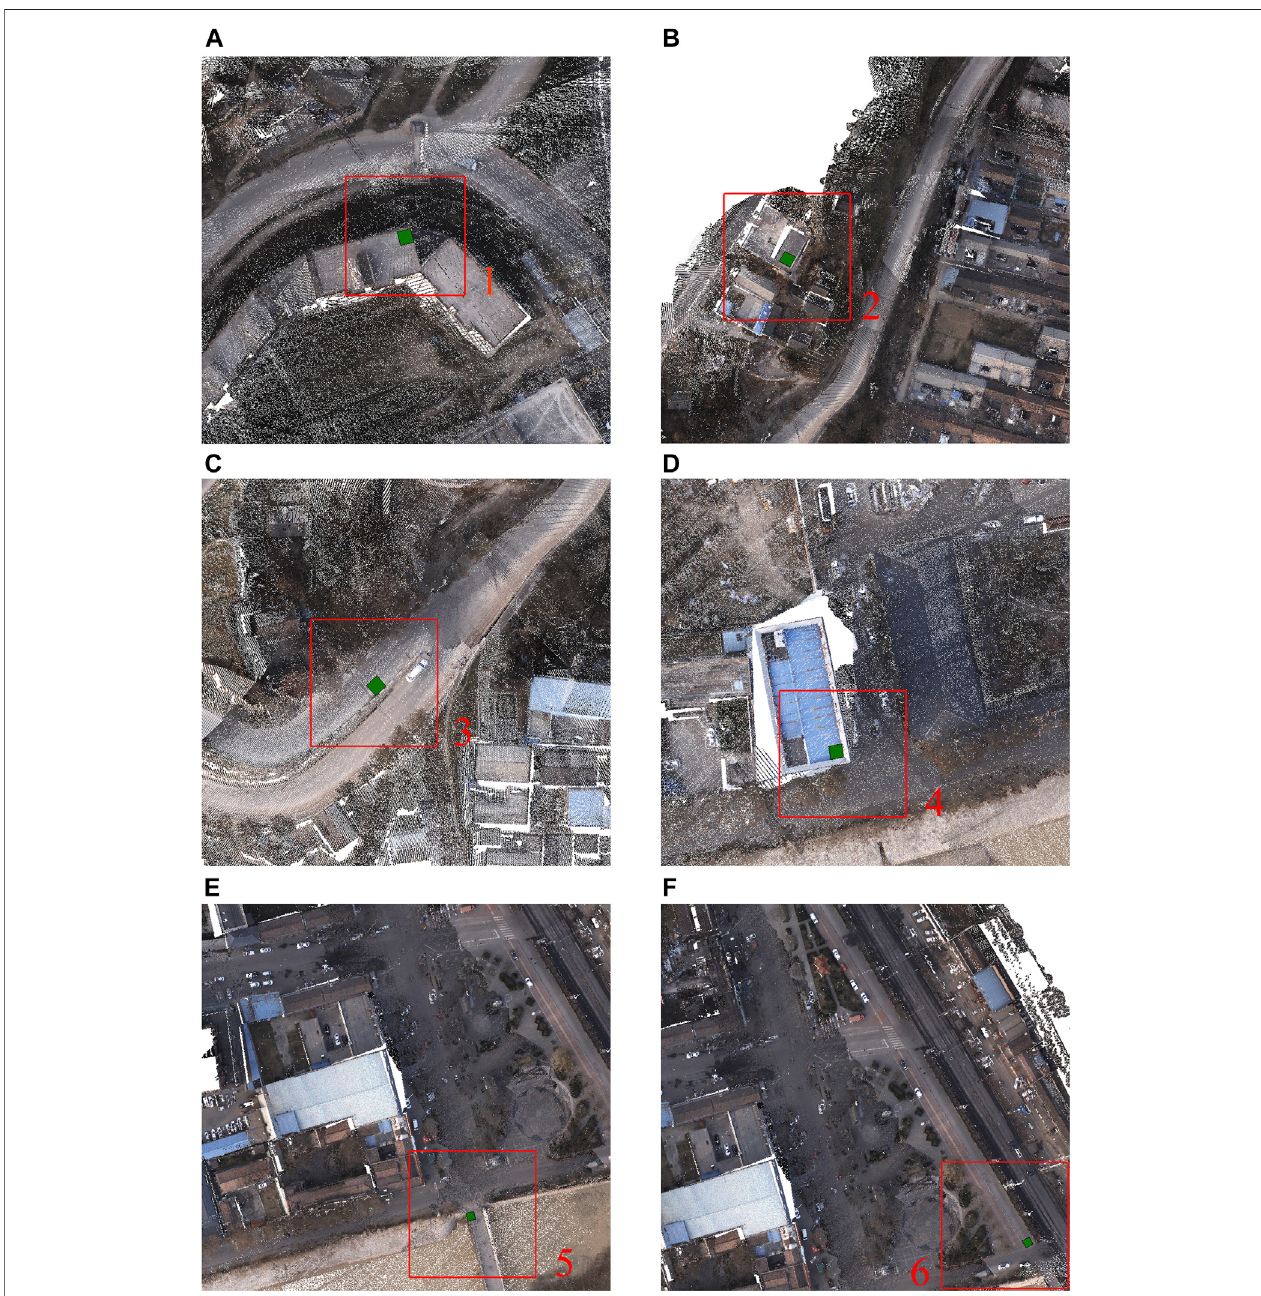
FIGURE 11 | Sketch map of datum point. (A) , (B) , (C) , (D) , (E) , and (F) are schematic locations of datum points 1,2,3,4,5, and 6, respectively.